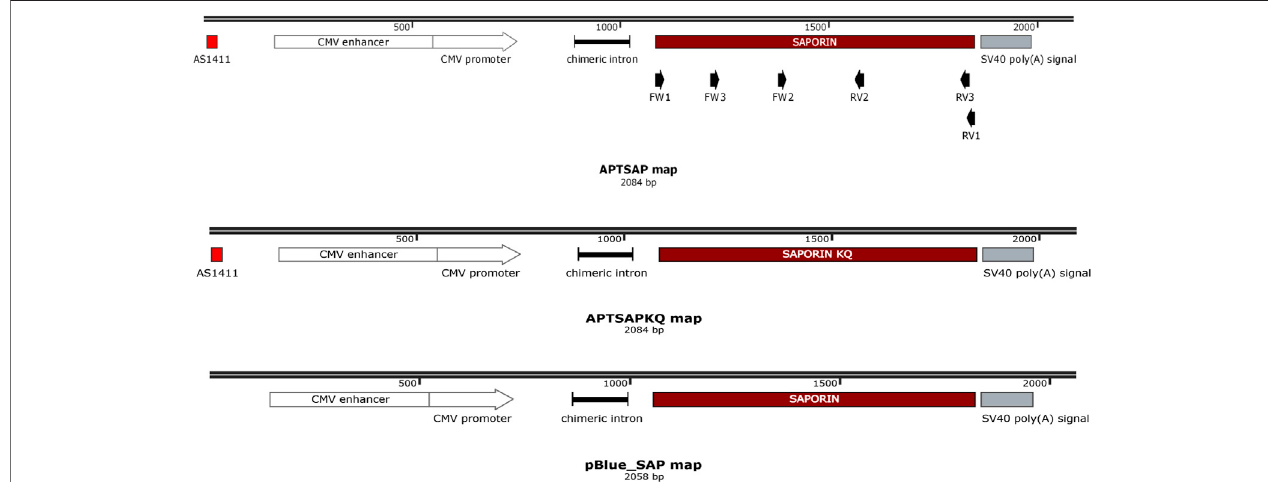
FIGURE 1 | Schematic representation of APTSAP, APTSAPKQ and pBlue_SAP DNA sequences. The nucleotide sequence of AS1411 [5 ′ -d (GGTGGTGGTGGT TGTGGTGGTGGTGG)-3] was placed at the 5 ′ terminus of a synthetic construct containing the CMV promoter, the saporin gene, a chimeric intron derived from pCI vector,andapoly-adenylationsignalatthe3 ′ terminusandinsertedintopBluescriptIIKS(+)vectorusingaSmaIrestrictionsite.IntheAPTSAPKQconstructthesaporin genesequencewassubstitutedwiththesaporinKQmutatedsequence.ThepBlue_SAPconstructlacksthe5 ′ AS1411aptamersequence.Intheschemewealso indicated the PCR primers at their relative positions (FW1/RV1, FW2/RV2, FW3/RV3). This map was created by the SnapGene Viewer freeware software ( “ SnapGene software ” from Insightful Science; available at